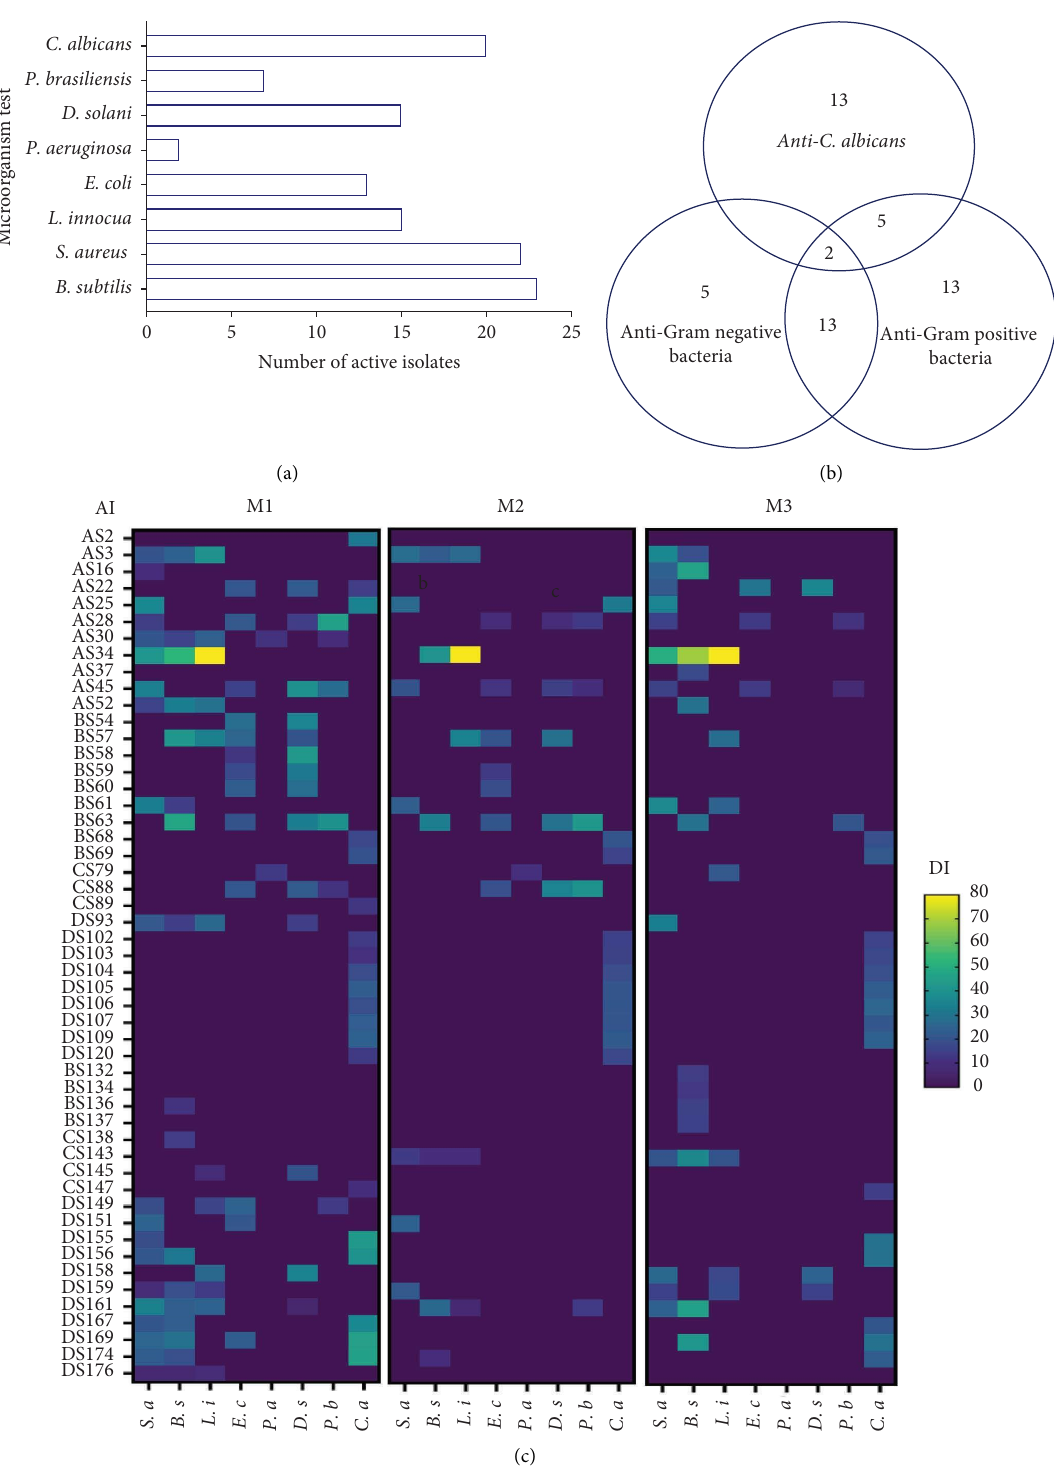
Figure 6: Antimicrobial activities. (a) Number of Actinobacteria isolates with antimicrobial activity broken down by indicator micro- organisms (detected in a mutually exclusive way on the three culture media). (b) Venn diagram summarizing the spectrum of activity of the 51 antimicrobial producing actinobacterial isolates. (c) Heatmap summarizing antimicrobial activities. M1: on Bennett’s medium; M2: on GYM medium; M3: on CSA medium; DI: diameter of the inhibition zone (given in mm); AI: Actinobacteria isolate; S . a : S . aureus ; B . s : B . subtilis ; L . i : L . innocua ; E . c : E . coli ; P . a : P . aeruginosa ; D . s ; D . solani ; P . b : P . brasiliensis ; C . a : C . albicans